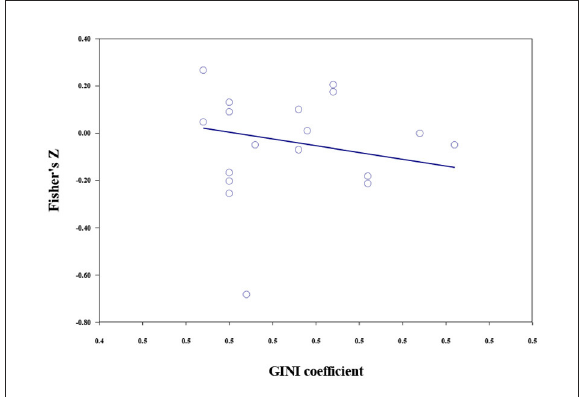
FIGURE7 The moderating role of the GINI coefficient in the association between extrinsic aspirations and subjective wellbeing.